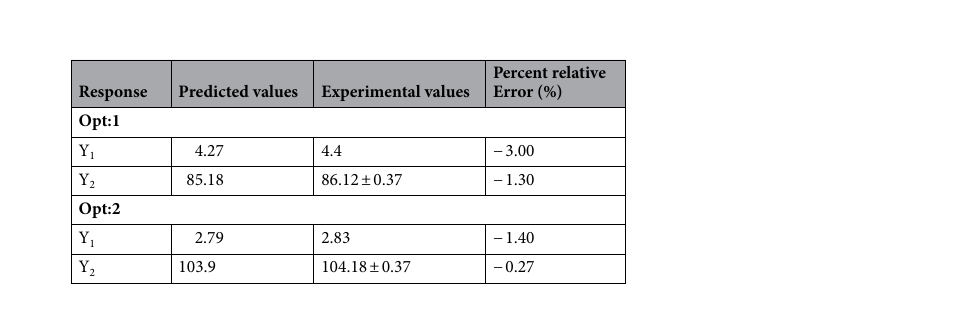
Table 7. Predicted and experimental values of the optimized extraction responses and their percent relative error.